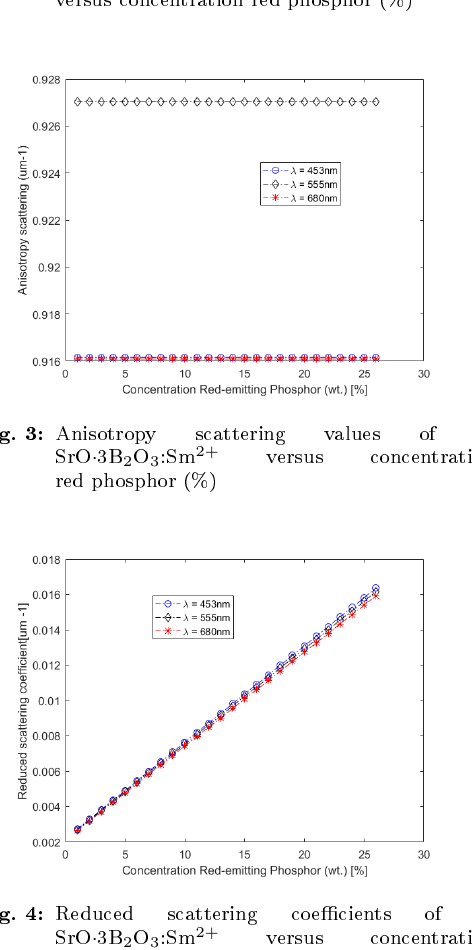
As demonstrated in Figure 5 and Fig- ure 6, both color rendering index (CRI) and color quality scale (CQS) grow with the α